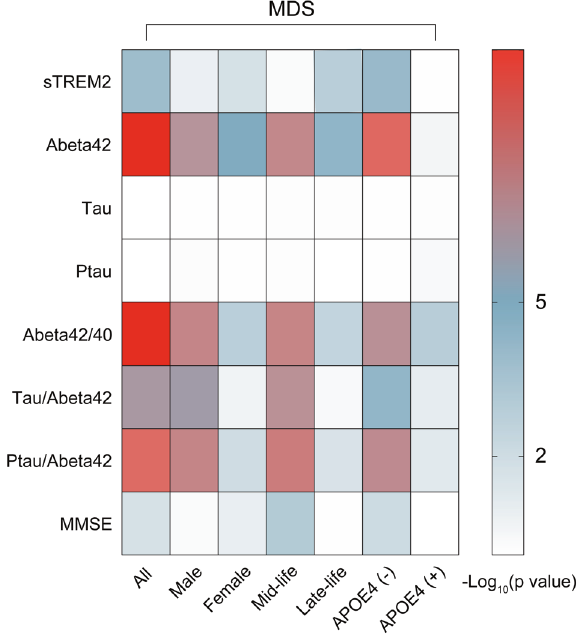
Fig. 2 Association of MDSs with CSF biomarkers and cognition. MDSs were signi fi cant associated with CSF sTREM2, CSF amyloid markers, and cognition in total and subgroups, but not with CSF tau and CSF p-tau. MDSs minimal depressive symptoms; APOE apolipoprotein gene; MMSE Mini-Mental State examination; CSF cerebrospinal fl uid; sTREM2 soluble triggering receptor expressed on myeloid cells 2; A β amyloid- β ; P-tau phosphorylated